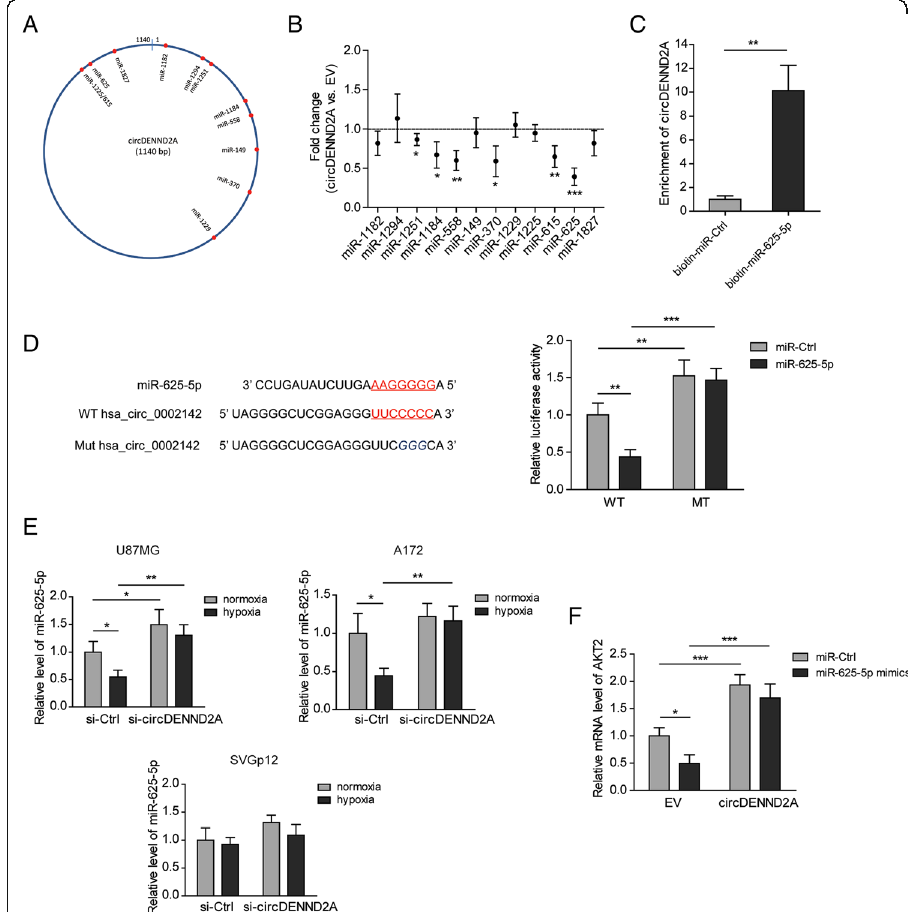
cells with overexpression of circDENND2A versus empty vector (EV) were determined by qPCR. c The levels of circDENND2A captured by biotinylated miR-625-5p or miR-Ctrl from U87MG cell lysates were measured by qPCR. d The luciferase activities of wild-type or mutant pGL3-control-circDENND2A in U87MG cells transfected with miR-625-5p or miR-Ctrl. e The levels of miR-625-5p in hypoxic or normoxic U87MG, A172, and SVGp12 cells with or without knockdown of circDENND2A were measured by qPCR. f The mRNA levels of AKT2 in U87MG cells transfected with circDENND2A or EV and miR-625-5p or miR-Ctrl were determined by qPCR. Data are shown as mean±SD (three independent repeats). * p <0.05, ** p <0.01, *** p